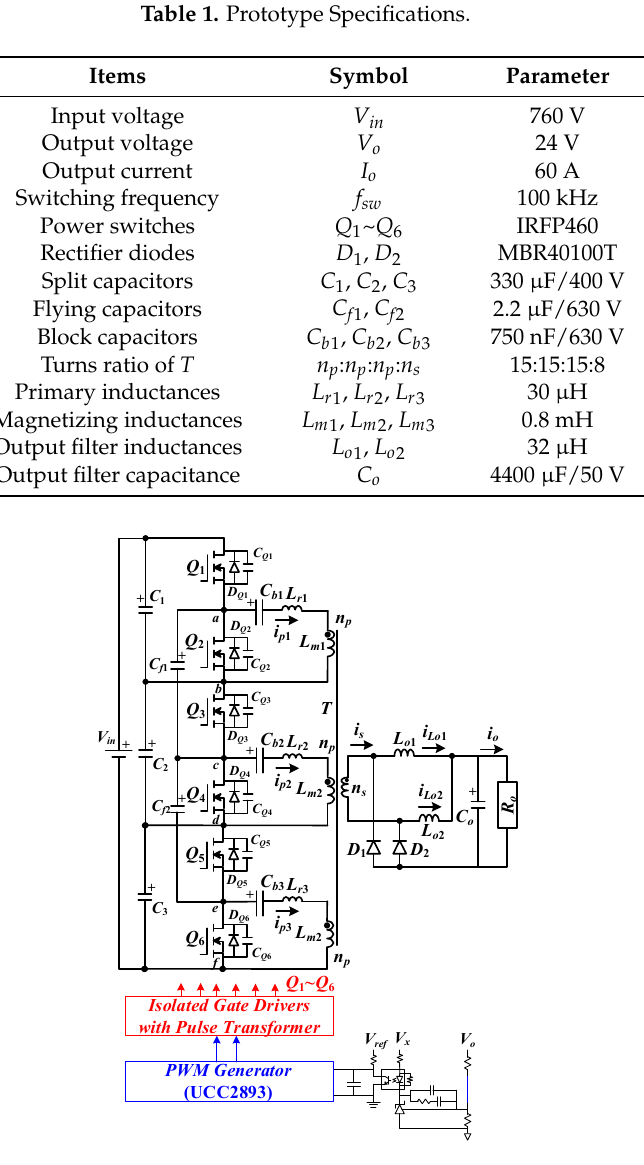
Figure 6. The experimental circuit diagram of the developed converter.